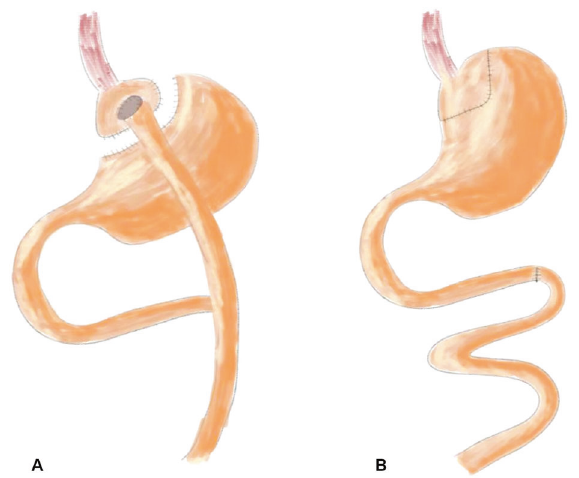
Fig. 1 The schema of surgical procedure. A The schema of Roux- en-Y gastric bypass. The food bypass the most stomach and reach to mid-jejunal. B The schema of sham Roux-en-Y gastric bypass. The sham surgery involved same incisions or transections without food